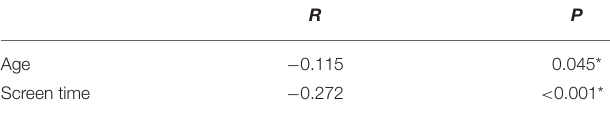
TABLE 3 | Correlations among vitamin D, age, and screen